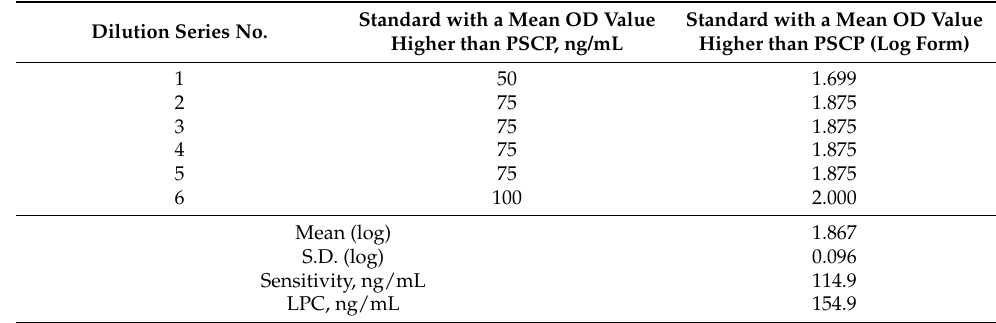
Table 4. Method sensitivity and LPC concentration calculations.